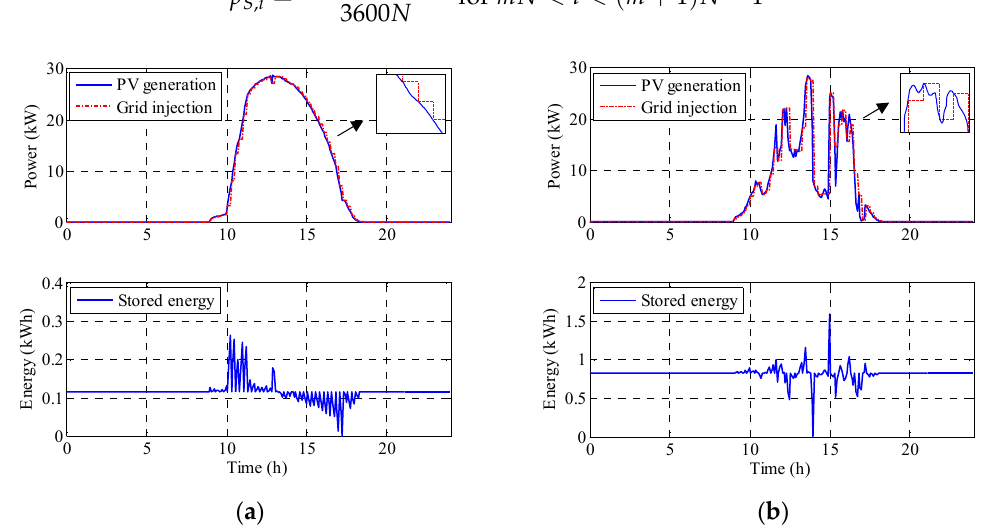
Figure 7. PV power generation, PV power injected into the grid (obtained from the PV power generation at the end of the previous 15-min interval) and the energy stored: ( a ) for a sunny day and ( b ) for a cloudy day.